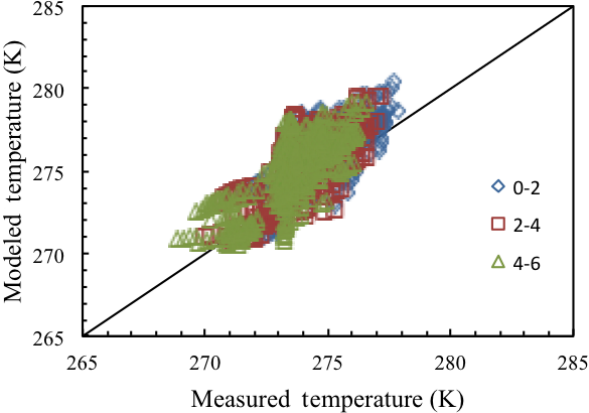
Figure 6. Scatter plot of measured and modeled temperature for Site 11 at the surface for the LE Rain model showing the positive temperature bias overnight.